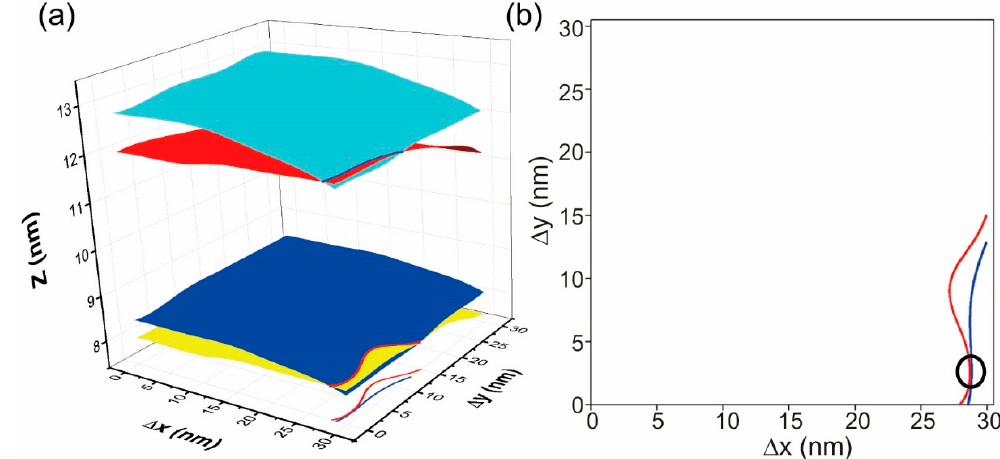
Figure 8. ( a ) 3D surface mapping of absorption cross-section peak wavelengths of mode 1 and mode 2 for the upper air gap and the lower air gap for the movement of the central block, Δ x = 30 nm, Δ y = 0 nm, and Δ z = 2 nm. The surfaces indicate the positions of the center block, where the absorption wavelength is maintained as constant. Mode 1 (P1, 852.1 nm) and mode 2 (P3, 1017.5 nm) for the lower gap of 12 nm are represented by red and cyan, respectively. Mode 1 (P2, 953.3 nm) and mode 2 (P4, 1148.3 nm) for the upper gap of 8 nm are indicated by yellow and blue, respectively. Red and blue lines represent the line of the intersection of the two surfaces, P2 and P4, P1 and P3, respectively, which are projected on an x– y plane. ( b ) The projection of the two red and blue lines on the x – y plane. The black circle indicates the cross-sectional point.